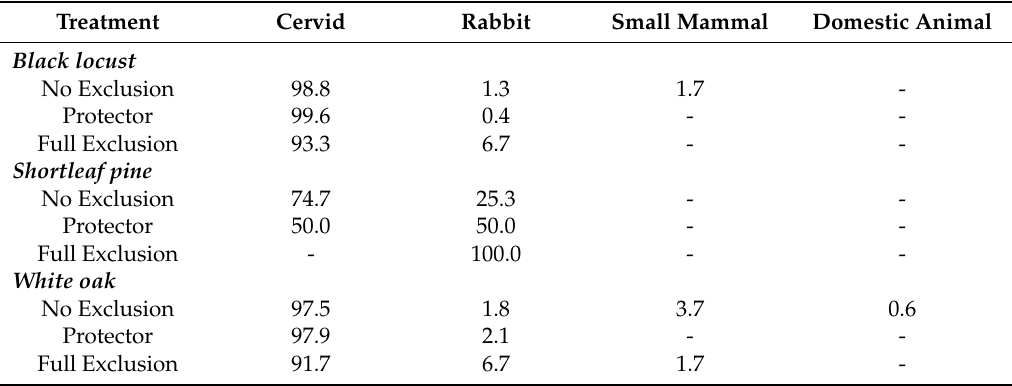
Table 4. Relative herbivore contribution (%) to herbivory incidence by tree species and exclusion treatment on reclaimed mined land in southeastern KY. Damage of a seedling by multiple taxa results in total contributions greater than